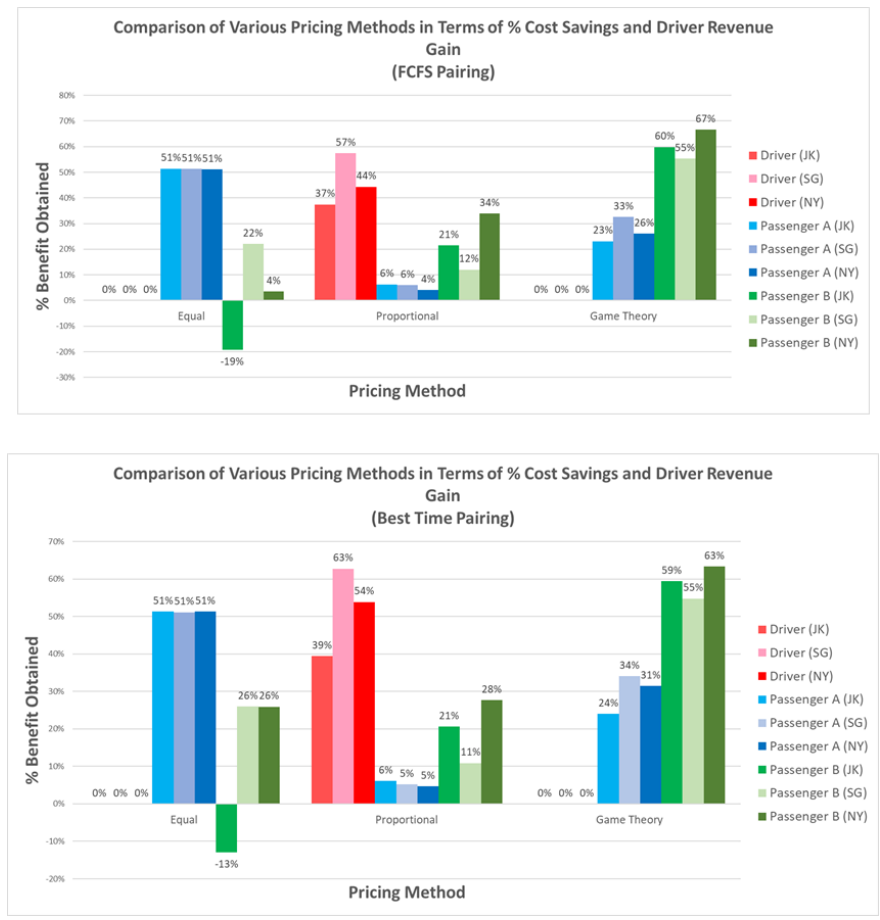
Figure 8. Passenger Cost Savings and Addition Driver Revenue (in %) for FCFS ( top ) and BT ( bottom